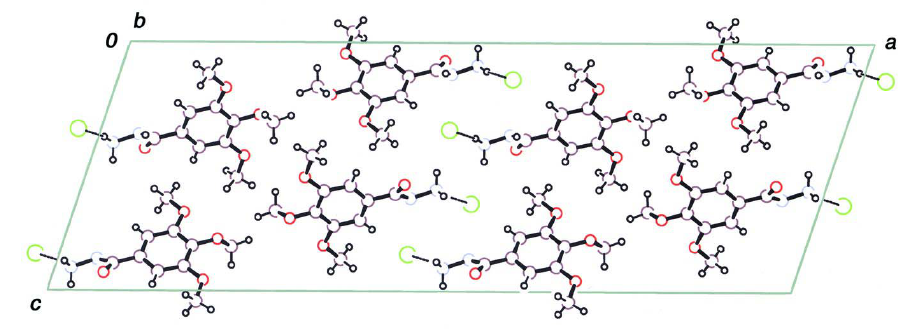
Figure 3 A crystal packing diagram, viewed along the b